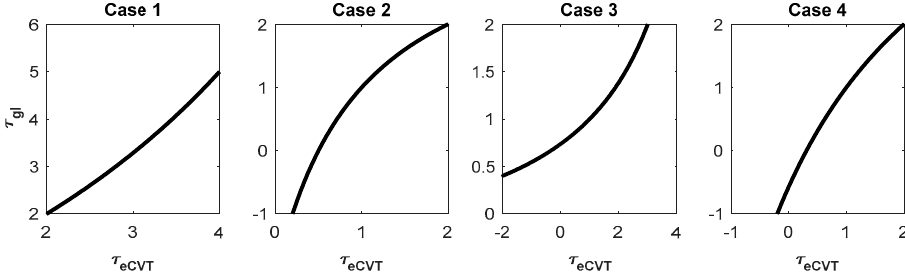
Figure 2. Power flows types within a Type B compound transmission: 12 possible flows ( a – i , l – n ) with different power circulations.